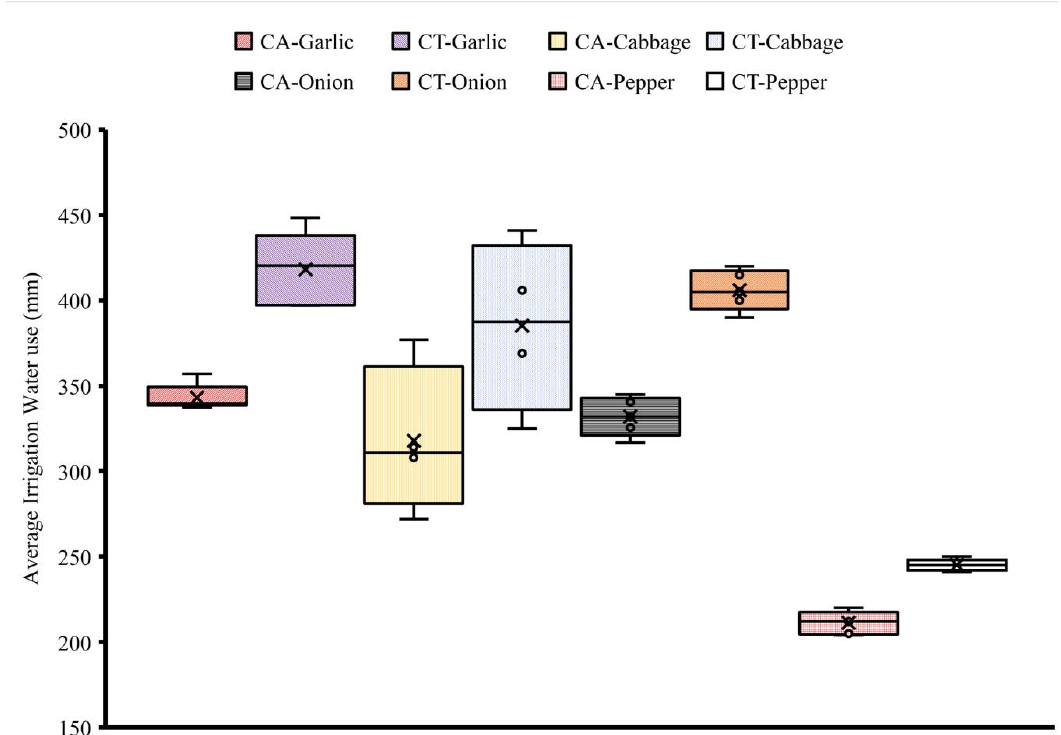
Figure 5. Average irrigation water uses for cabbage, garlic, onion, and pepper in Dangishta and Robit under CA and CT plots.